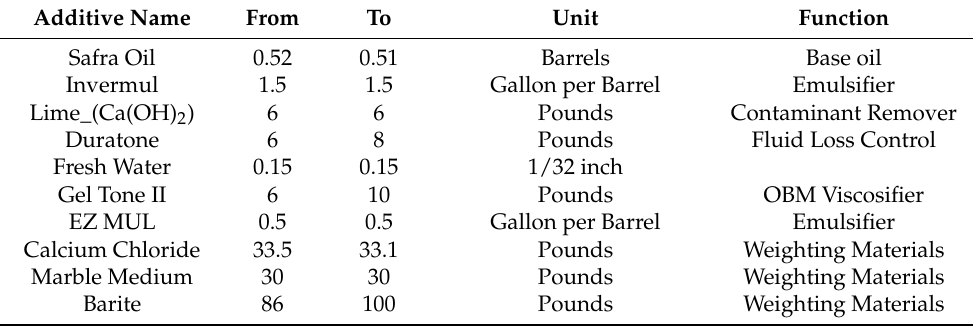
Figure 9. EDS analysis of the worn casing sample (S2) tested under oil-based wet conditions at 115 rpm and 1000 N. Table 4. The composition of the oil-based drilling fluid, as received from the oil company